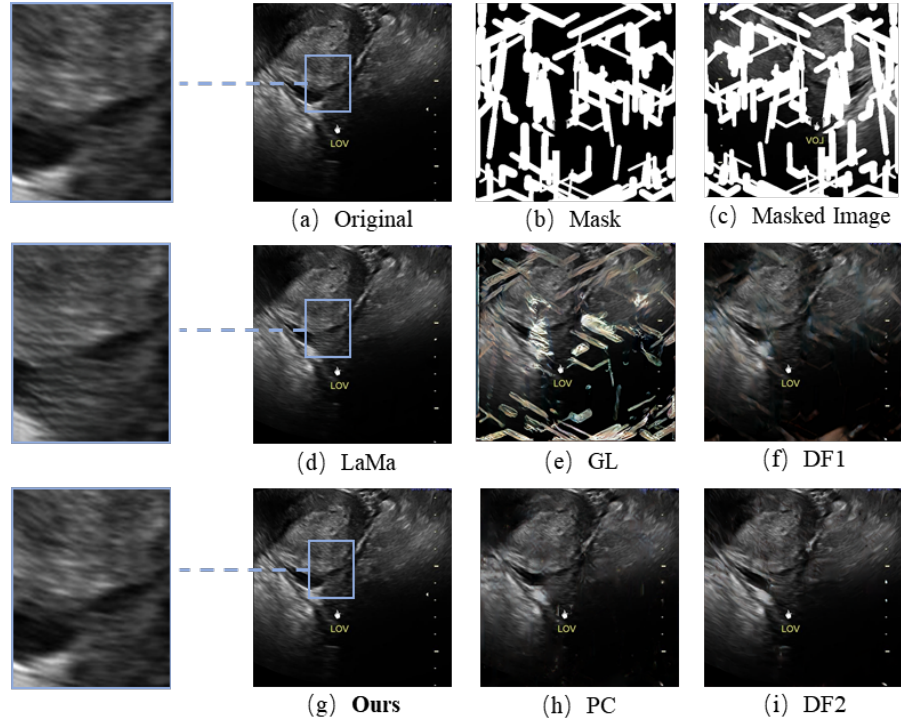
Figure 8. Comparison between the results of our proposed model and other models. ( a ) The original image. ( b ) The mask for the original image. ( c ) The masked image. ( d ) Results from publicly available code using the LaMa method. ( e ) Results from publicly available code using the GL method.